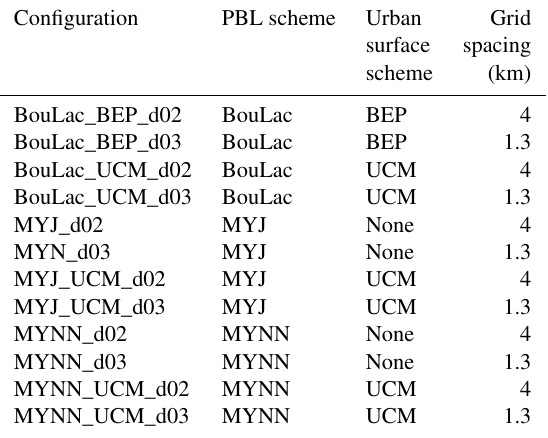
Table 2. WRF configurations used for the sensitivity